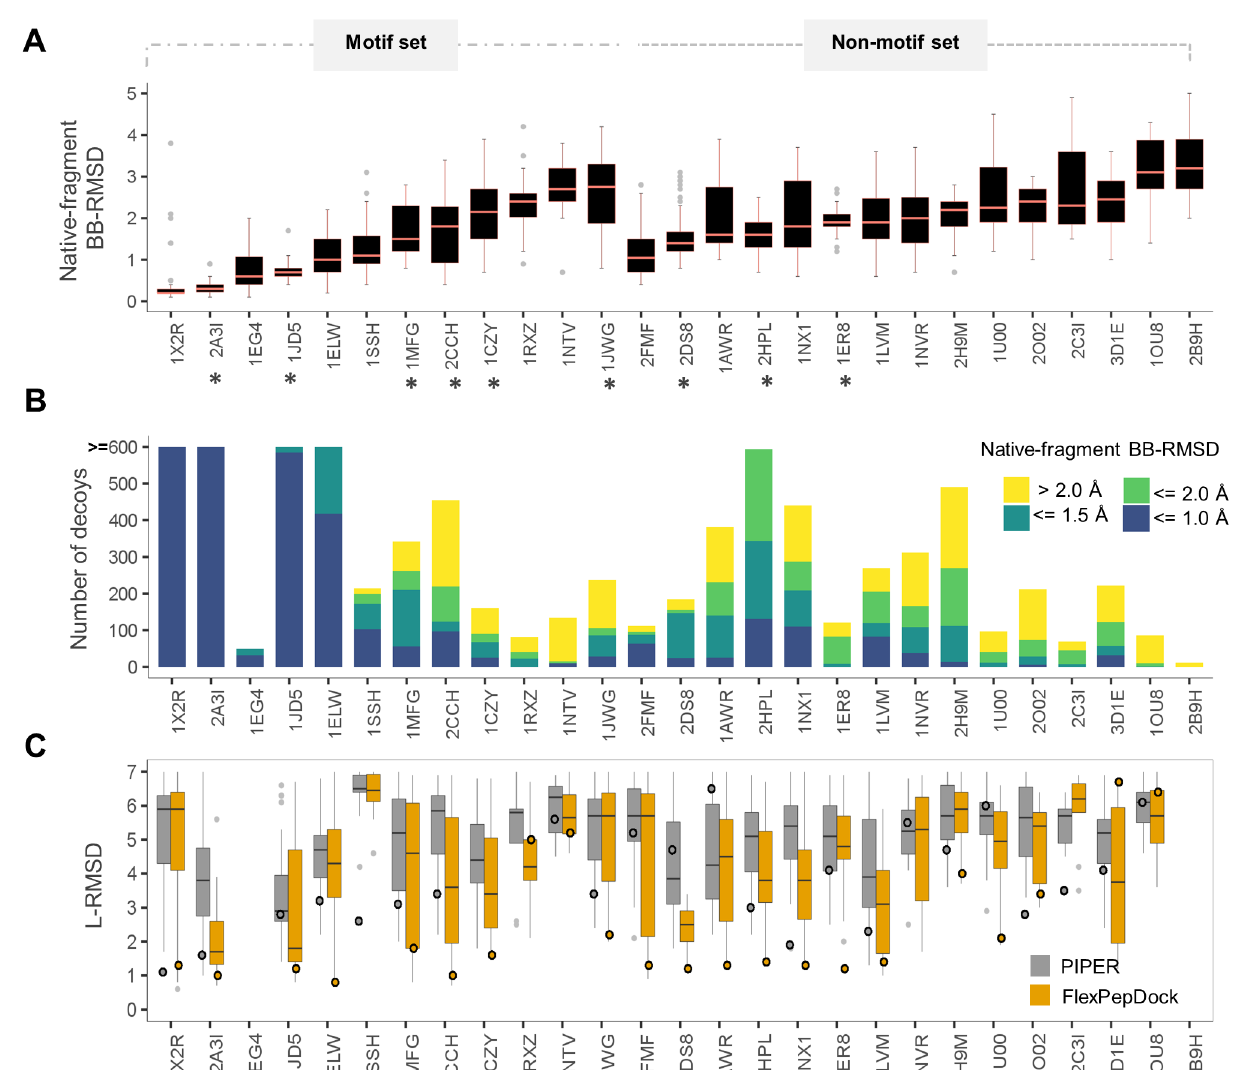
Fig 2. Assessment of performance of the different steps of PIPER-FlexPepDock. (A) Fragment quality: distribution of fragment backbone RMSDs relative to the native bound peptide conformation (defined as fragment quality). PDBs with and without motif information are grouped separately. The initial calibration set is marked with asterisks ( (cid:3) ). (B) PIPER rigid body docking: distribution of the number of models within 5 Å ligand (L)-RMSD from the native, colored according to fragment quality. (C) Improvement after FlexPepDock refinement: distribution of the L-RMSDs of the top 1% FlexPepDock refined models (in orange) and corresponding PIPER models (in gray). Shown are the results of runs starting from the unbound receptor structure and including receptor minimizations (see also Fig 3). The circles represent the L-RMSD values of the best model among the top 10 ranking clusters. The Y-axis has been trimmed to 7Å. Note that for the PIPER runs, circles represent the top-ranked model of a PIPER run (including density clustering, as described in Methods and Porter et al . [24]), while the distributions represent the subset of models that served as starting structures for the models selected after FlexPepDock refinement. The former allows the comparison of the final results from a PIPER run to a corresponding PIPER-FlexPepDock run, while the latter shows improvement due to FlexPepDock refinement for the finally selected models.